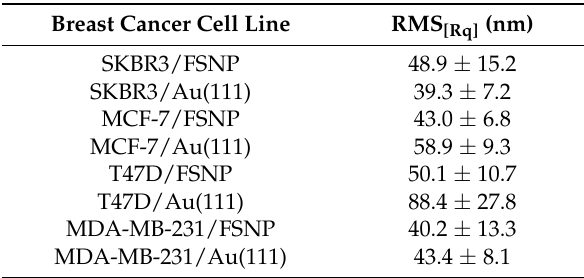
Table 1. Measurements of the surface roughness by AFM of the different breast cancer cell plasma membranes. The results are shown as: mean ± S.D.